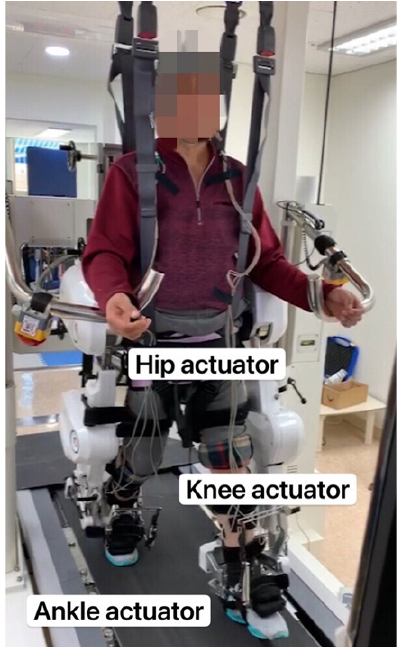
Figure 2. Walkbot system